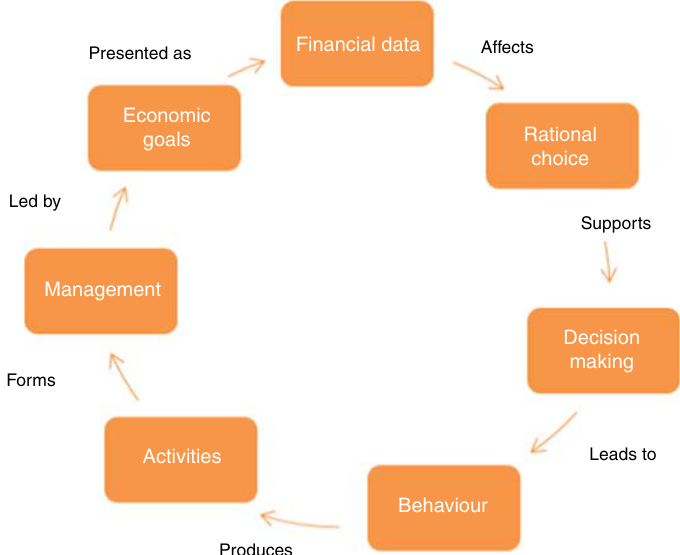
Figure 1. The link between financial data and